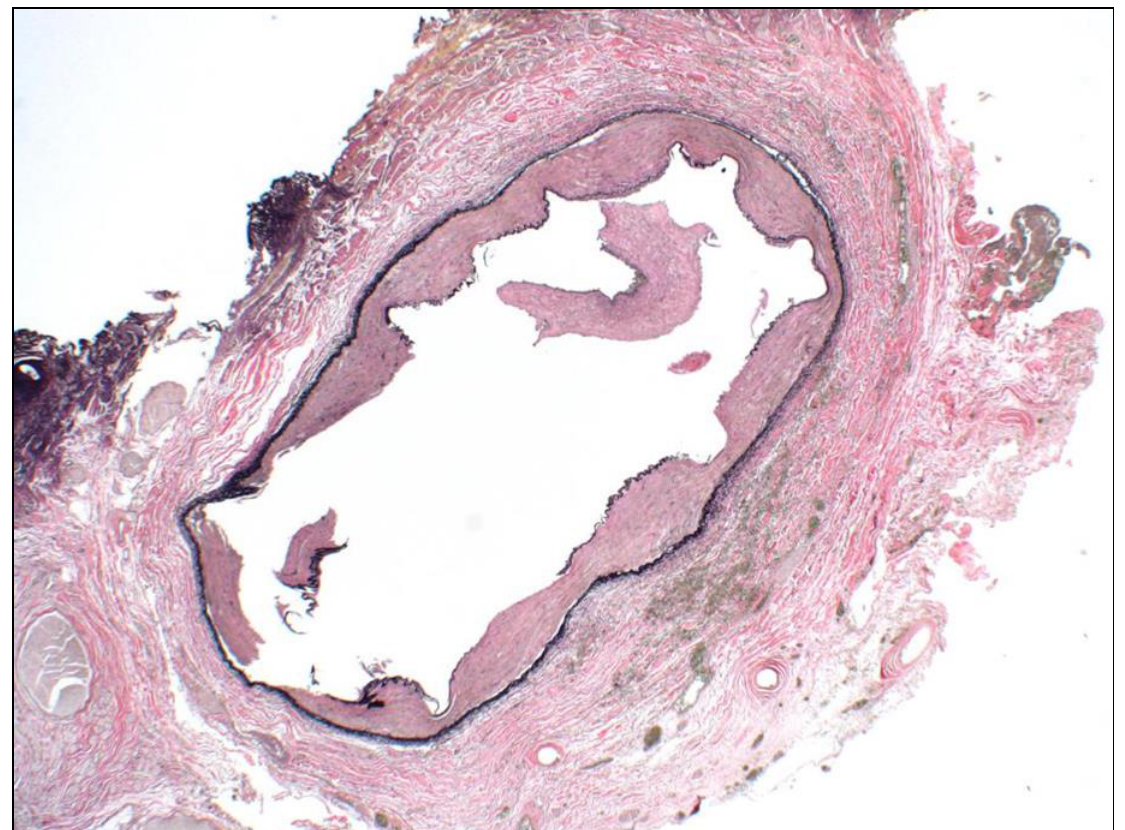
Figure 4. Representative photomicrograph of a resected, cross-sectioned, previously stented portion of a hepatic artery. The specimen is from the area of the previous anastomosis and is shown after electrolytic dissolution of the stent by reverse electroplating. Mild intimal atherosclerosis is present, which predates the insertion of the stent, but there is no neointima formation on the luminal side of the stent or on the surfaces of the struts. The vessel remains widely patent. Multiple indentations from the stent struts are still present in the intima, even though the stent was dissolved. Focal fragments of intimal atherosclerosis are present in the lumen, but this finding is an artifact from tissue processing. (Verhoeff–Van Gieson elastic stain, original magnification ×